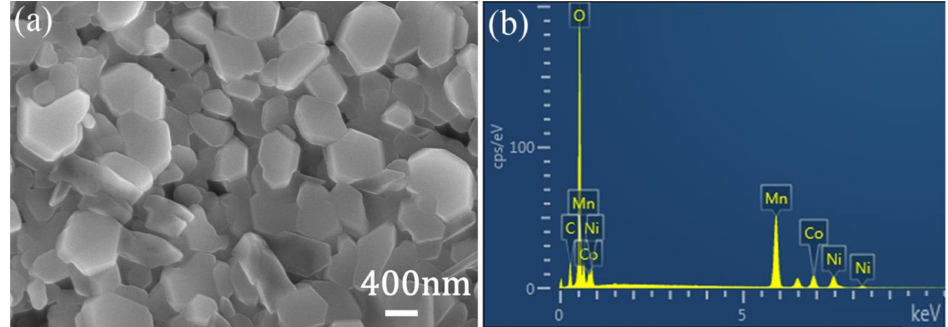
Figure 1. ( a )SEMimagesand( b )energy-dispersiveX-ray(EDX)spectrumoftheLi[Li 0.2 Ni 0.13 Mn 0.54 Co 0.13 ]O 2